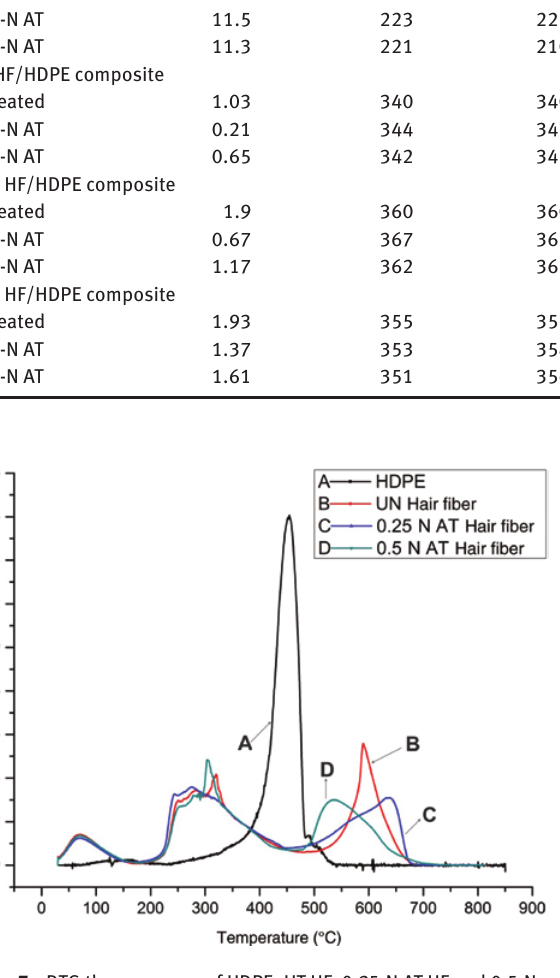
Figure 7: DTG thermograms of HDPE, UT HF, 0.25-N AT HF and 0.5-N AT HF.